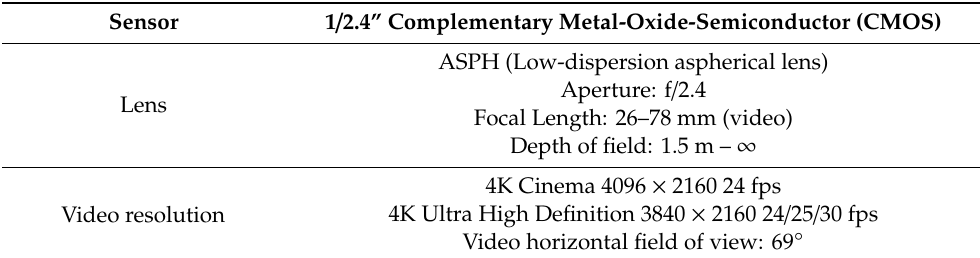
Table 5. Specifications regarding the imaging system of the ownership.